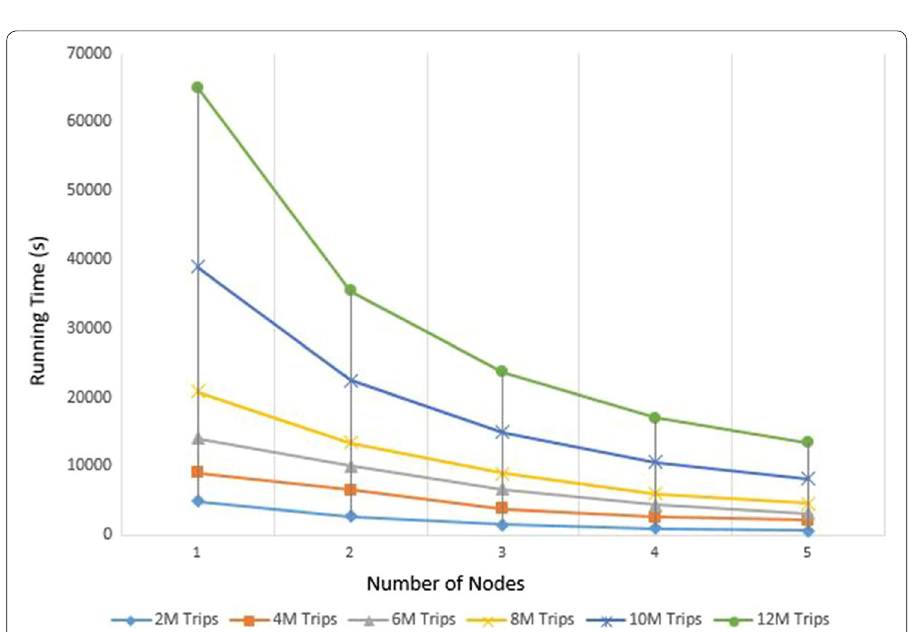
Fig. 16 Processing time of location traces on cluster of five